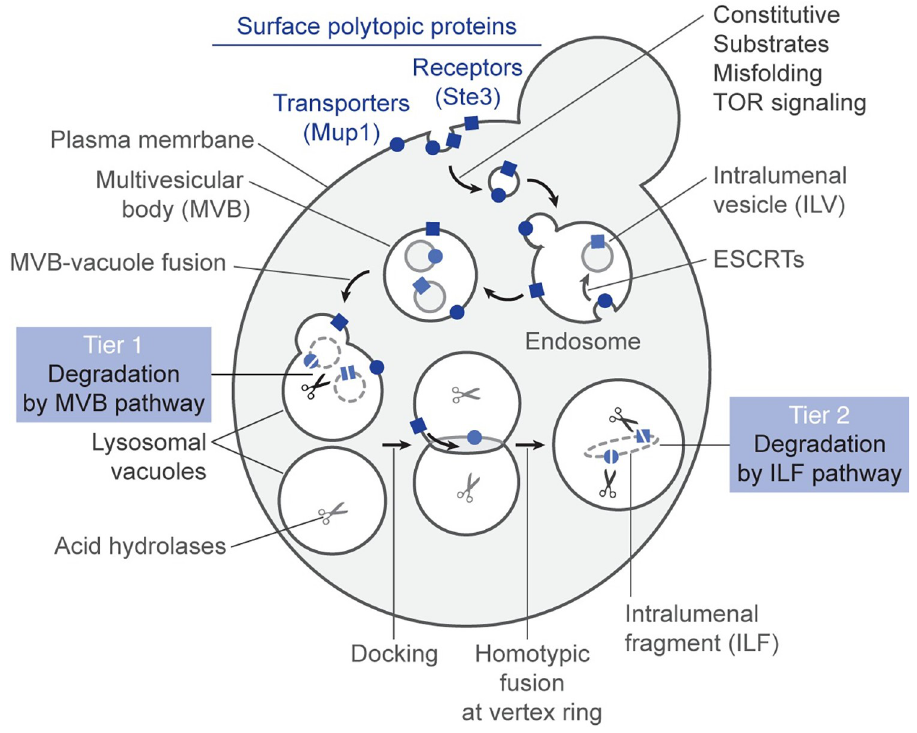
Fig 7. A two-tiered system ensures surface polytopic protein down-regulation. Illustration showing how surface transporter and receptor proteins like Mup1 and Ste3, respectively, are degraded by a two-tiered system consisting of the MVB and ILF